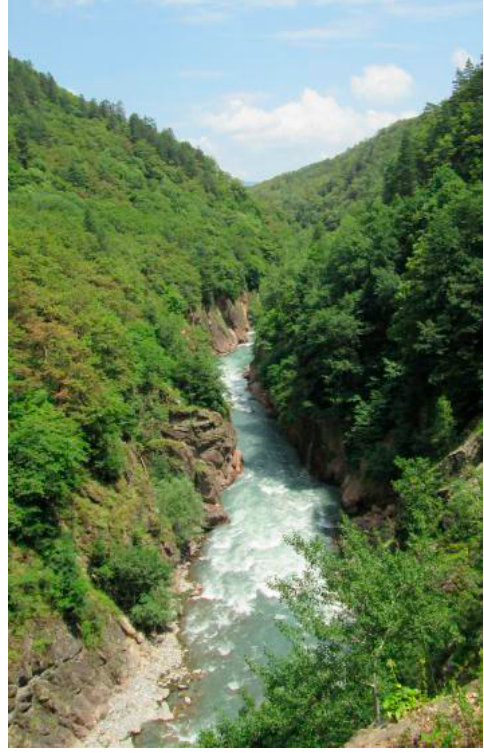
Figure 5. General view of the Granite Gorge near the northern entrance. The combination of V- and U-shaped gorge profiles, granitoid outcrops, and the Belaya River are visible.